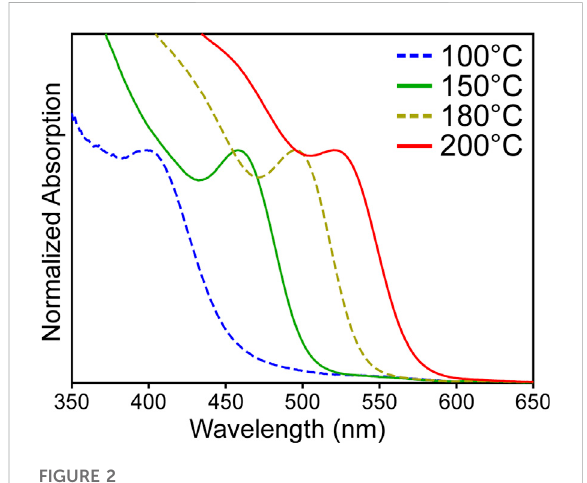
FIGURE 2 The normalized absorption of (NMe 4 ) 4 [Cd 10 Se 4 (SPh) 16 ] cluster seeded CdSe QDs nucleated in a single-stage reactor at various